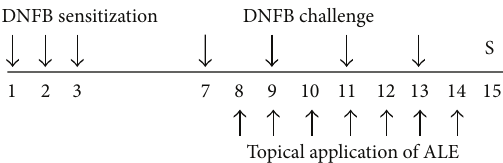
Figure 1: Experimental schedule. Mice in all experimental groups were sensitized by DNFB for three successive days and then chal- lenged every other day (four times). The ALE group was topically treated with 30 or 300 𝜇 g/ear of ALE ( 𝑛 = 8 ). The DEX group was topically treated with 75 𝜇 g/ear of DEX for seven days from day 8 to day 14 ( 𝑛 = 6 ). All animals were sacrificed on day 15. S indicates